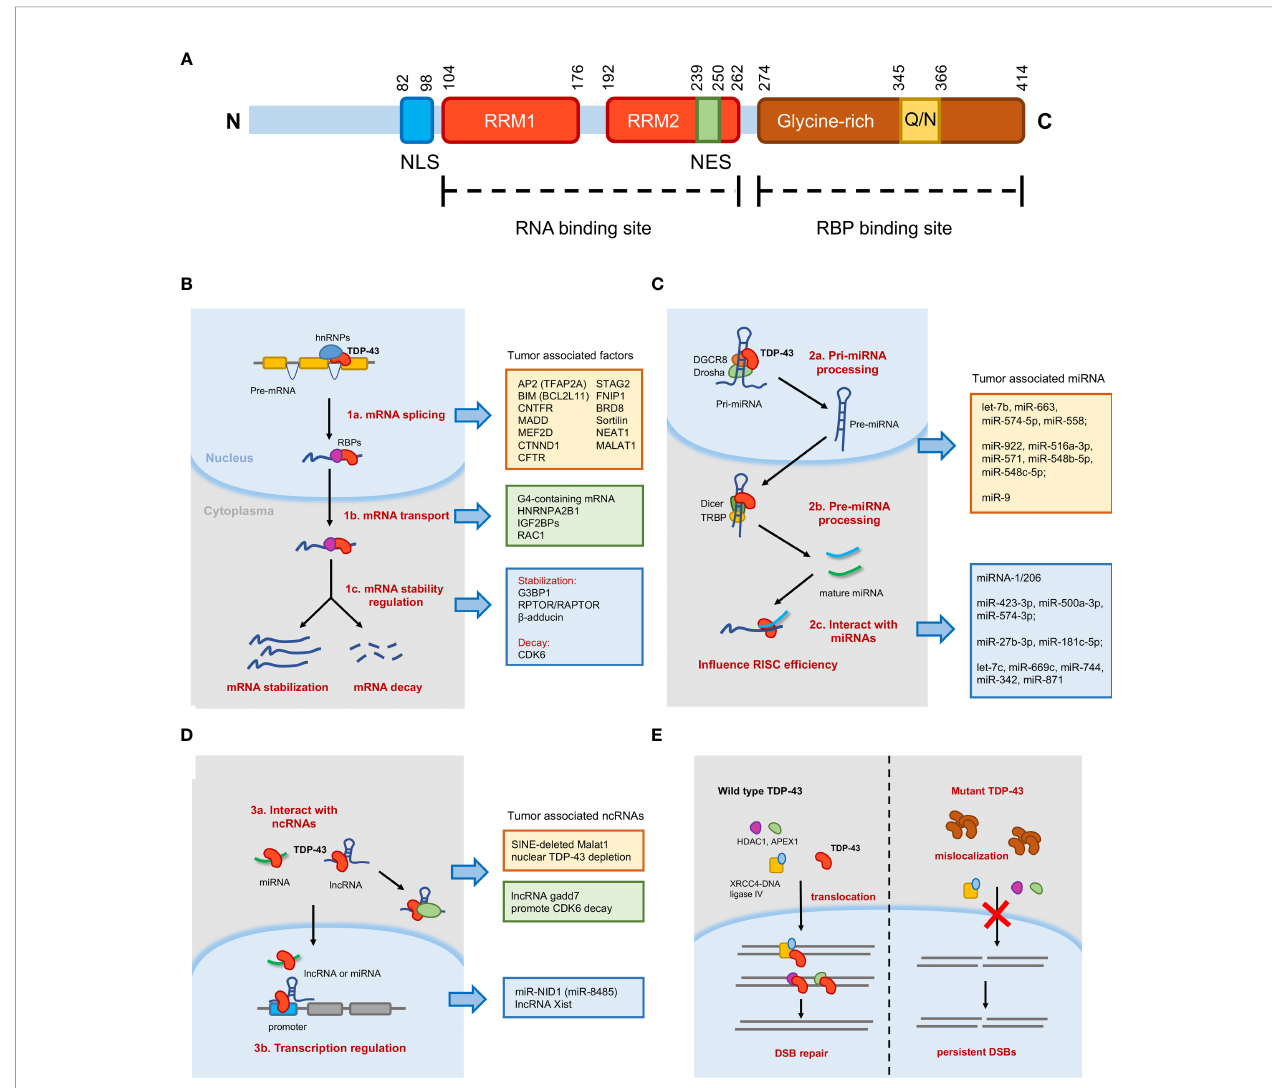
FIGURE 1 | Schematic diagram of TAR-DNA-binding protein-43 (TDP-43) domain structure and molecular mechanisms mediated by TDP-43. (A) TDP-43 protein contains 414 amino acids, an N-terminal domain (NTD), two RNA recognition motif (RRM1 and RRM2) domains, a glutamine/asparagine-rich (Q/N) and glycine-rich C-terminal region, and two singles (bipartite nuclear localization signal and nuclear export signal). (B) In the nucleus, TDP-43 is essential for messenger RNA (mRNA) splicing and transport. In the cytoplasm, TDP-43 regulates mRNA stability, including mRNA stabilization and mRNA decay. (C) TDP-43 participates in microRNA (miRNA) processing as well as interacts with mature miRNAs to in fl uence RNA-induced silencing complex (RISC) ef fi ciency. (D) TDP-43 could interact with long non- coding RNA (lncRNA) or miRNA to regulate transcription. TDP-43 could also bind lncRNA to regulate target proteins. (E) Model of TDP-43 function in DNA damage repair. In normal cells, TDP-43 helps in the nuclear import of double-strand break (DSB) repair proteins and stimulates DSB repair. The mutant TDP-43 (Q331K, A382T) reduces mislocalization in the cytoplasm and abrogates the nuclear localization of DSB repair proteins, resulting in the accumulation of DSBs and upregulated DNA damage